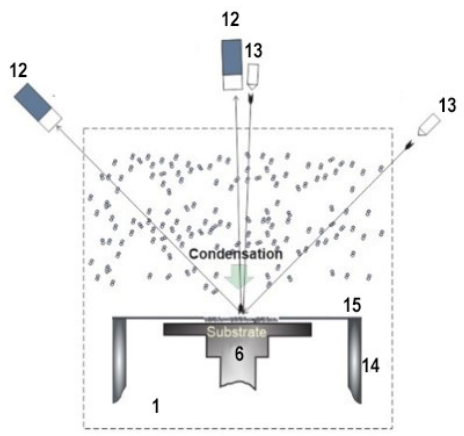
Figure 4. Experimental setup for laser-beam patterning during cryovacuum condensation: 6: sub- strate, 12: photoelectric multiplier, 13: laser, 1: vacuum chamber, 14: metal cylinder, 15: shield. Number labelling follows that of Figure 3. Reproduced with permission from A.U. Aldiyarov, Re- fractive Index at Low Temperature of 478 Tetrachloromethane and Tetrafluoroethane Cryovacuum Condensates; published by ACS Omega, 2020 [2].